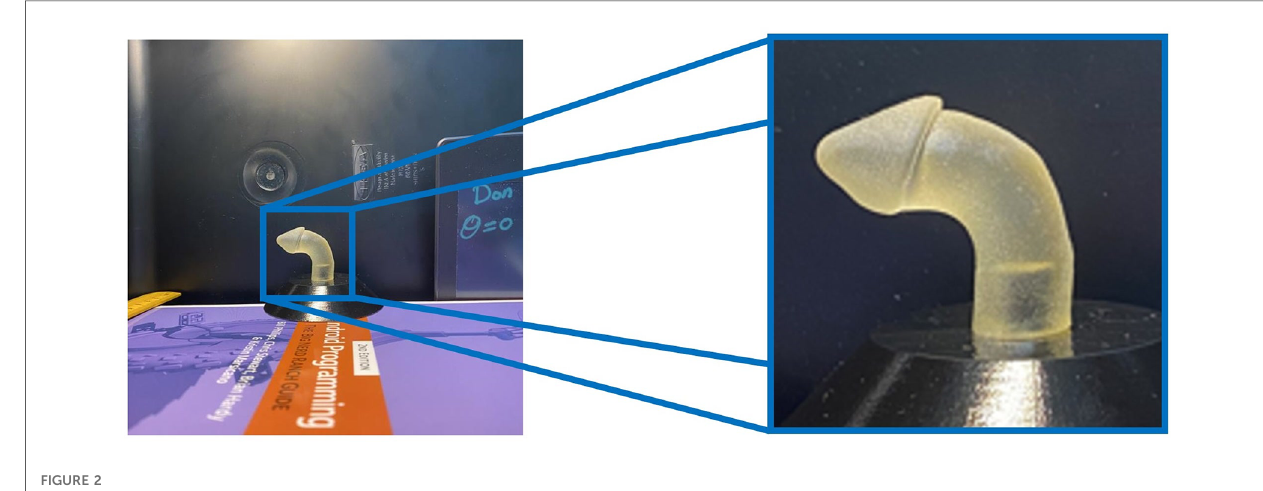
FIGURE 2 Penile area localization and